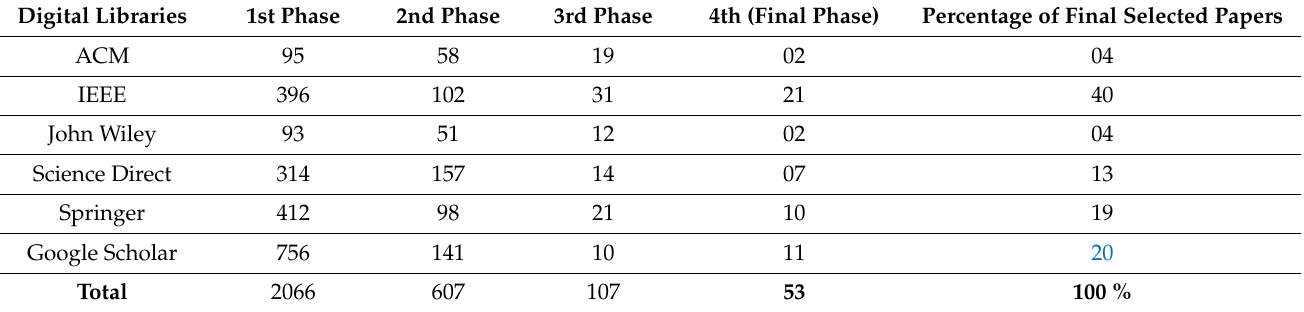
Table 3. Results of selecting articles.